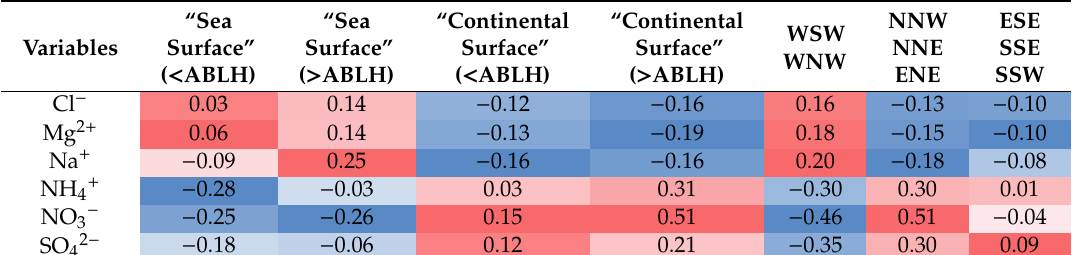
Table 2. PLS correlation matrix between chemical variables and both zone and clustered sector variables. Highest correlation displayed in dark red and highest anti-correlation in dark